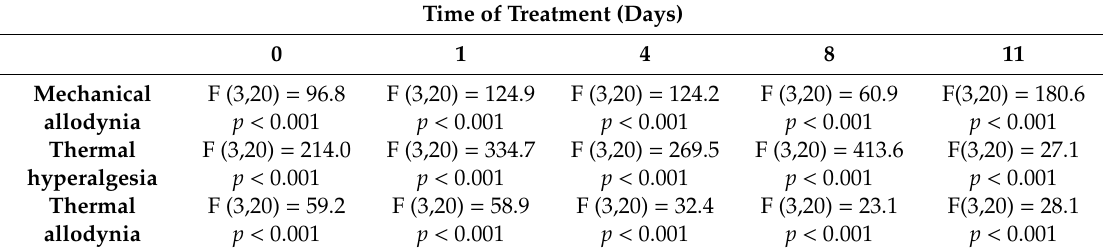
Table 1. Summary of the one-way ANOVA performed with the data obtained for mechanical allodynia, thermal hyperalgesia, and thermal allodynia at di ff erent times (0, 1, 4, 8, and 11 days) after vehicle or oltipraz administration in the sham-operated and chronic constriction of the sciatic nerve (CCI)-injured